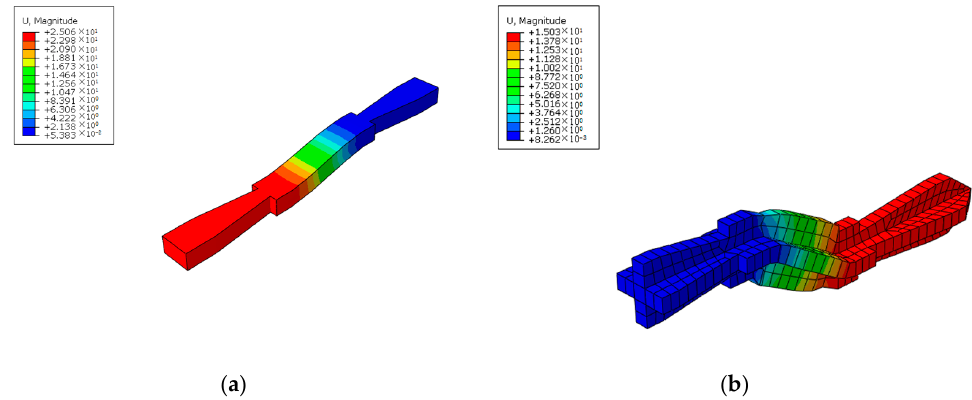
Figure 18. Displacement cloud diagrams of connector. ( a ) L1 connector; ( b ) L2 connector.